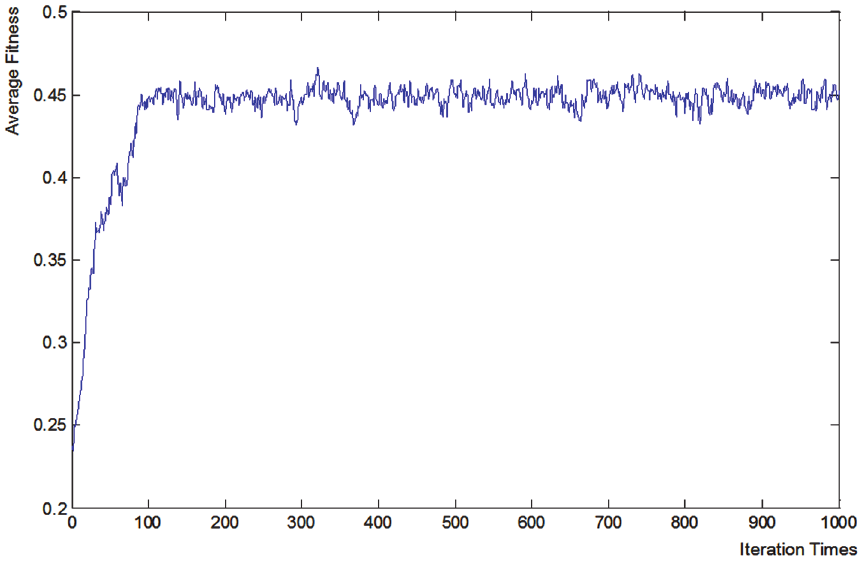
Figure 6. Relationships between population average fitness and iteration times